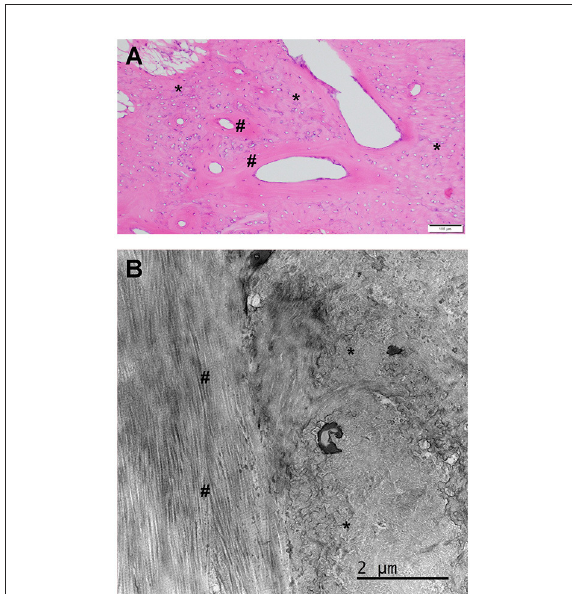
FIGURE3 (A) Standard HE histology of the muscle biopsy from case 2. There is no apparent muscular tissue in the section presented. Instead, there is a mixture of mature lamellar (number sign) and immature woven bone (asterisk). The clear oval spaces were probably occupied by blood vessels that were lost in the processing. (B) Transmission electron microscopy for the interface between the woven (right, asterisk) and lamellar bone (left, number sign). Note the regimented and parallel collagen fiber alignment in the lamellar bone and the more haphazard and scrambled appearance of the collagen fibers in the woven bone. The dark areas represent mineralized portions of the bone matrix that were not completely removed by the decalcification